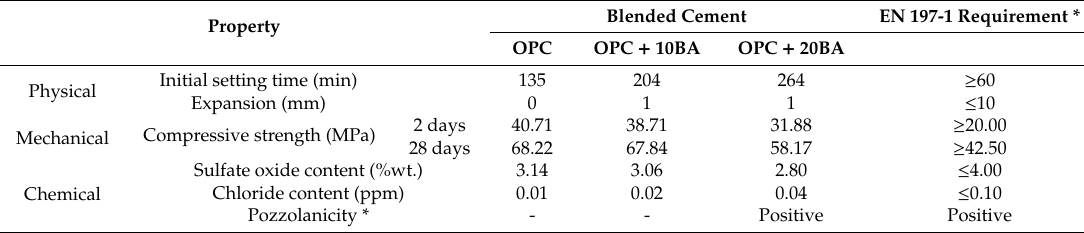
Table 1. New cement physical, mechanical and chemical properties